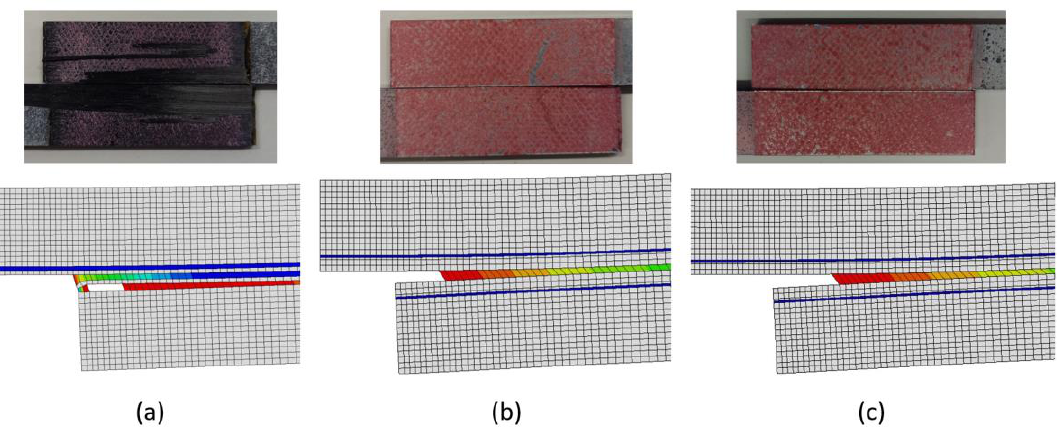
Figure 11. Experimental and numerical failure mode of the different geometries: ( a ) CFRP, ( b ) Al- CFRP-Al, and ( c ) CFRP-Al.